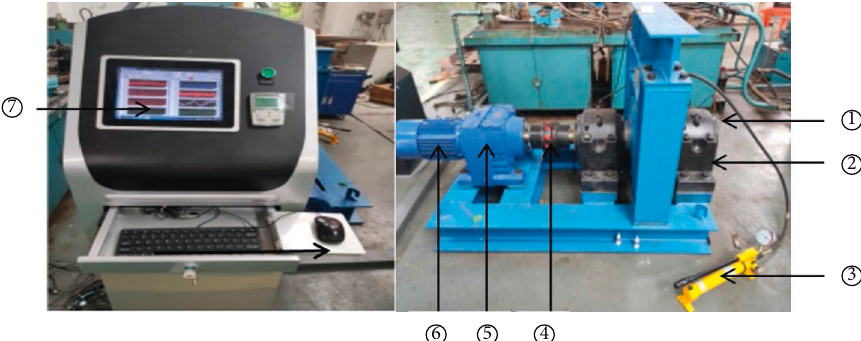
Figure 7: Fault test bench. ① Acceleration sensor. ② Experimental bearing. ③ Load pressurizing device. ④ Coupling. ⑤ Gearbox. ⑥ 3kW AC motor. ⑦ Signal acquisition